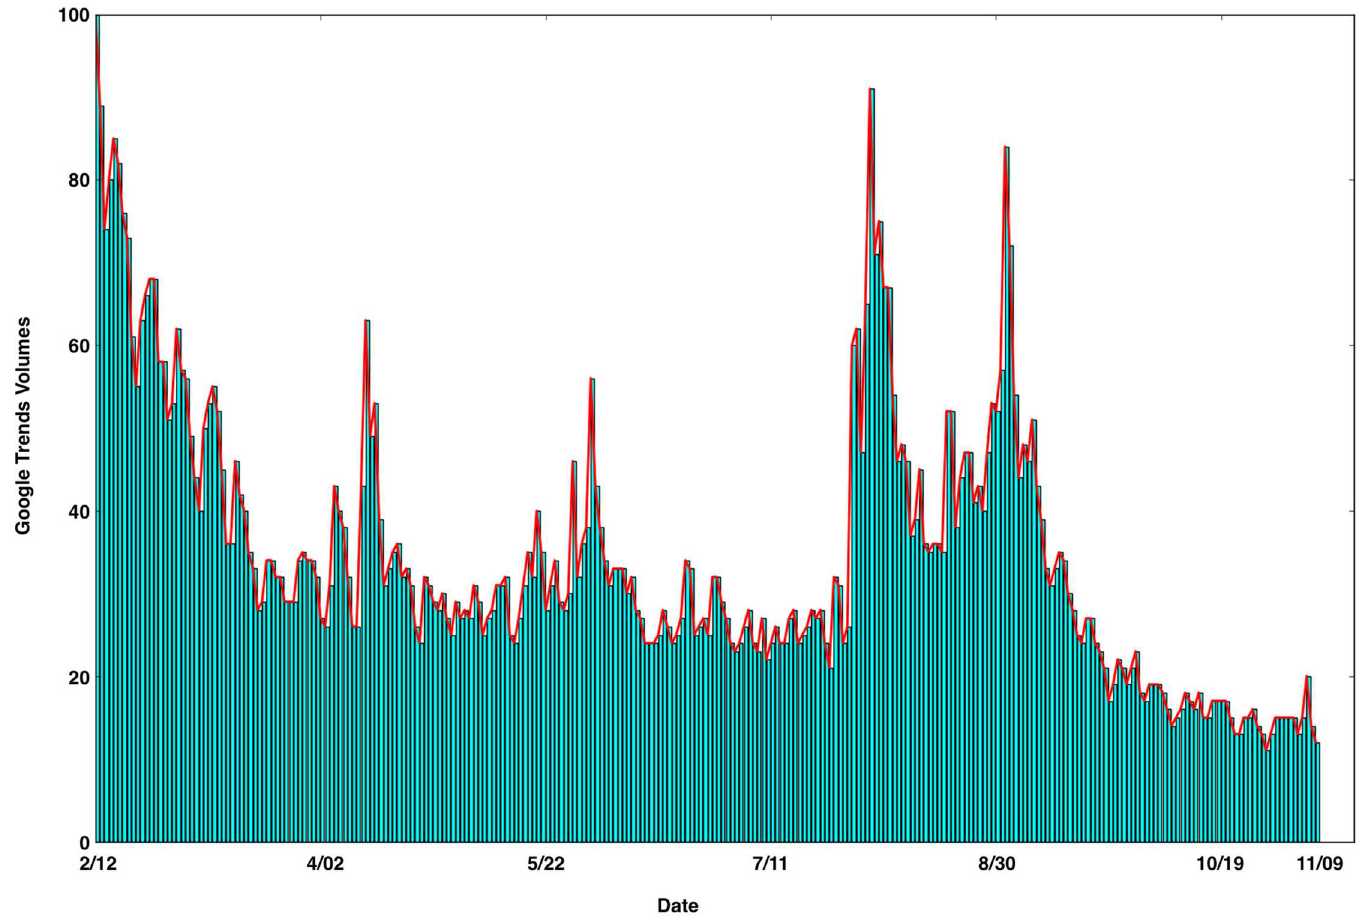
Fig 1. Time series plot of the daily GTs volumes from 12 February to 9 November2016 (Yearly EPI Week 6 to